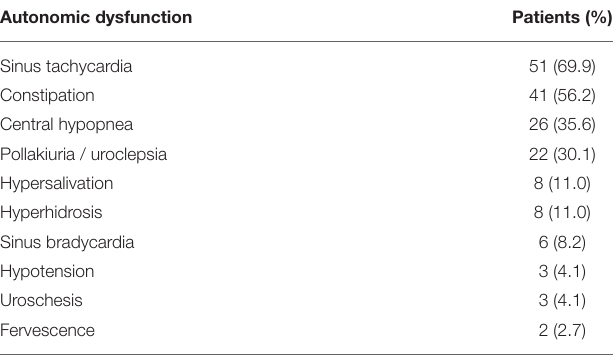
TABLE 1 | Clinical manifestation and incidence of autonomic dysfunction. Autonomic